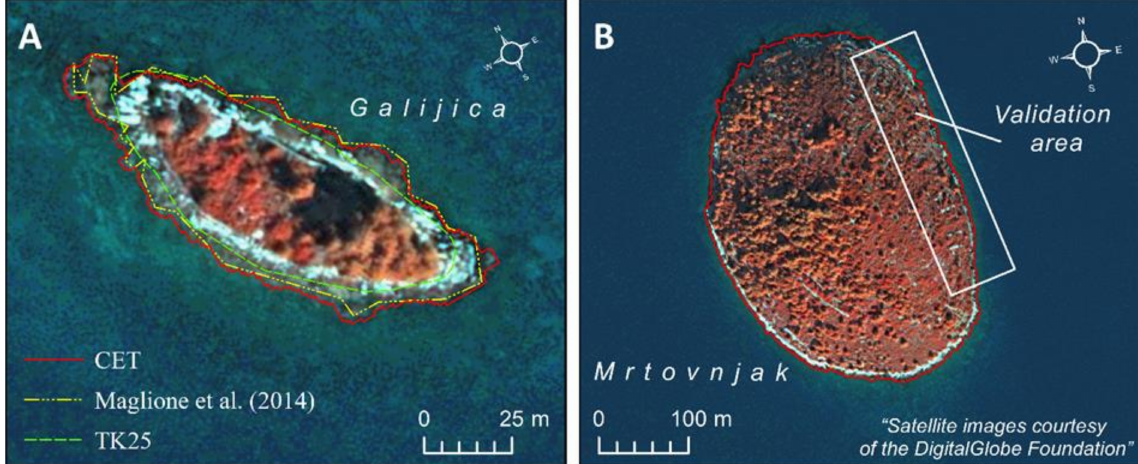
Figure 6. Comparison of CET-WV with two different datasets ( A ); location of the validation area within Mrtovnjak island ( B